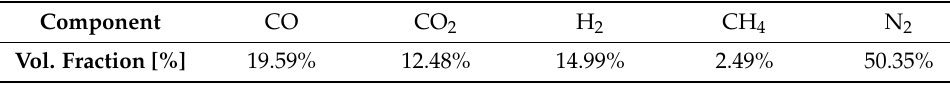
Table 2. Composition of the used syngas.